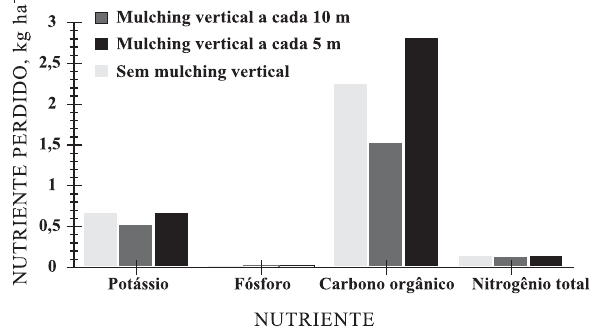
Figura 4. Perda de nutrientes e de carbono orgânico na água do escoamento superficial, obtida com chuva simulada com intensidade de 70 mm h -1 , em Latossolo Vermelho distrófico típico, durante o ciclo da cultura da soja, em semeadura direta, nos tratamentos sem vertical mulching , vertical mulching a cada 10 m e vertical mulching a cada 5 m.